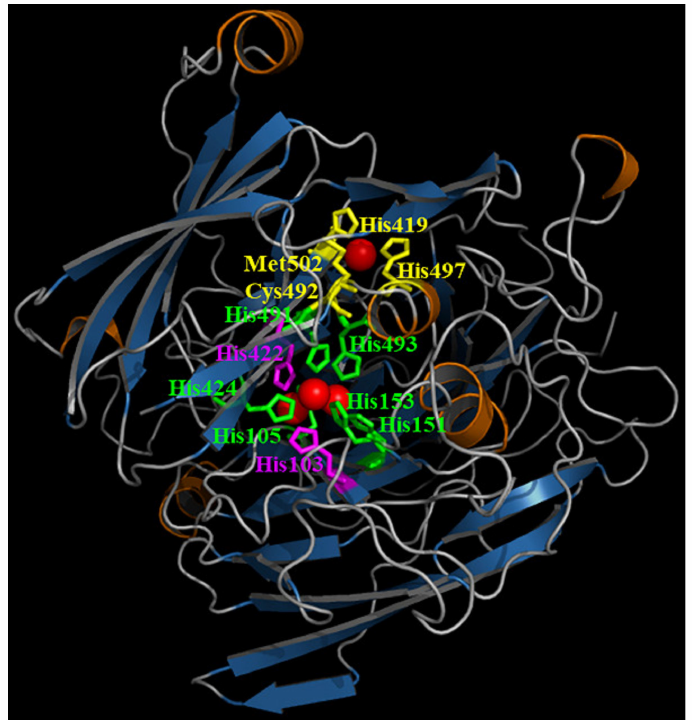
Figure 1. Homology model of the B. pumilus TCCC 11568 laccase. Three copper centers, including Type 1, Type 2, and Type 3, are depicted in yellow, purple, and green, respectively. The α -helices and β -sheets are denoted in orange and blue, respectively. Cu 2+ located at the active site of rLAC is labeled in